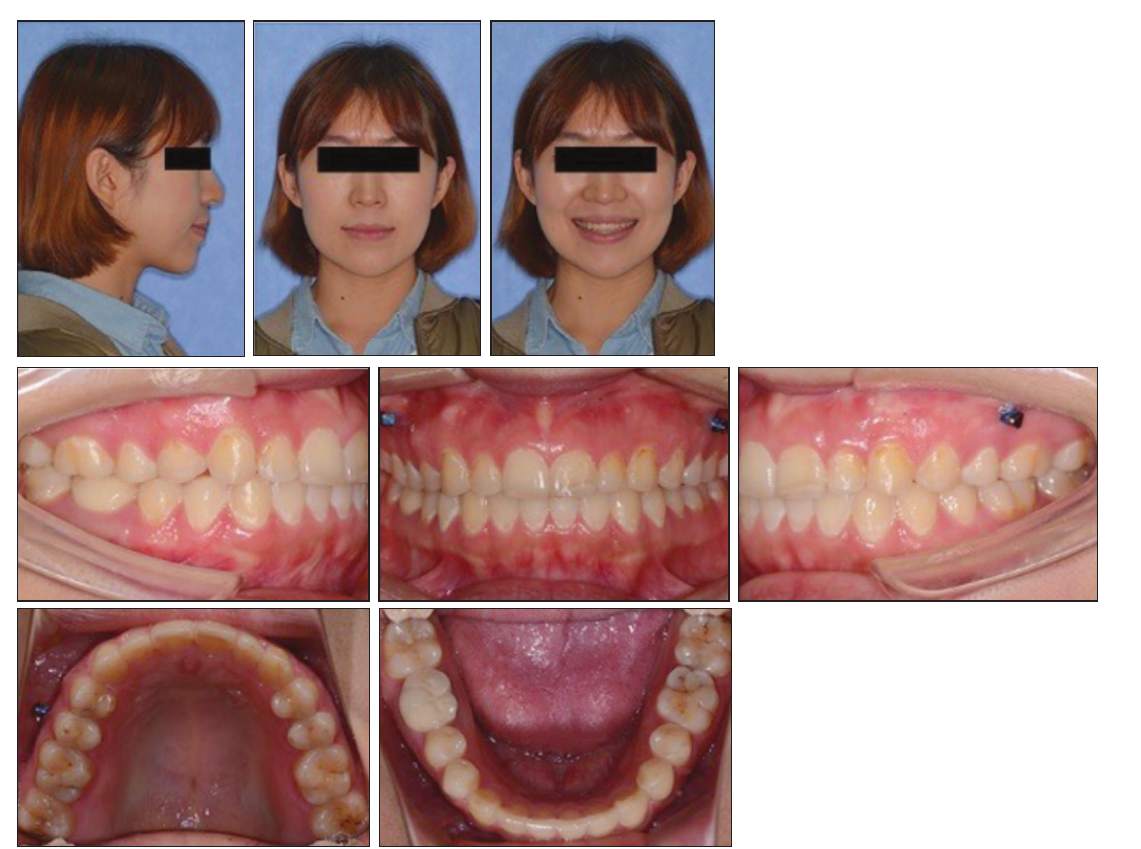
* + (-) indicate the values increased (decreased) after the treatment.